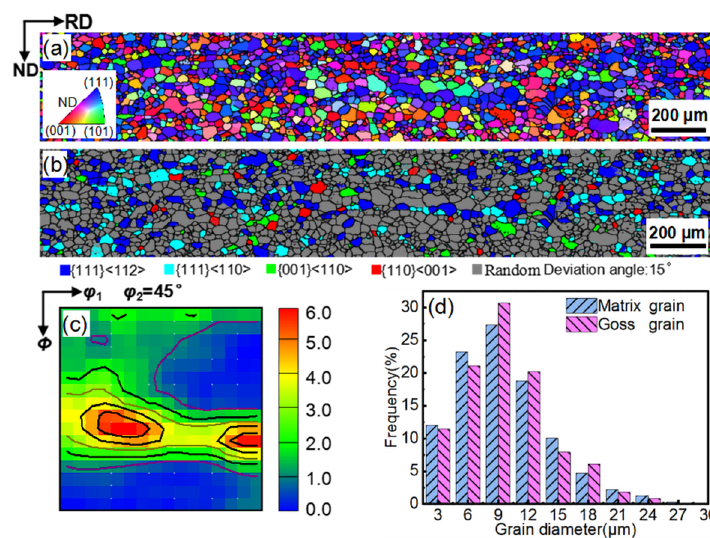
Figure 3. ( a ) Orientation image maps of all orientations, ( b ) several main texture components, ( c ) constant φ 2 = 45°section of ODF, and ( d ) grain-size distribution of all grains and Goss grains in the primary recrystallized Fe 81 Ga 19 thin sheet.